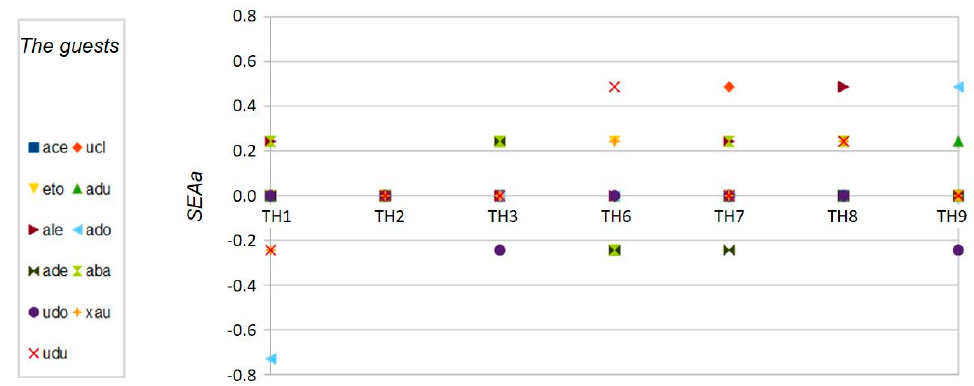
Figure 15. The normalized difference between final and initial self-evaluations by the guests of their proximities to the topic hubs